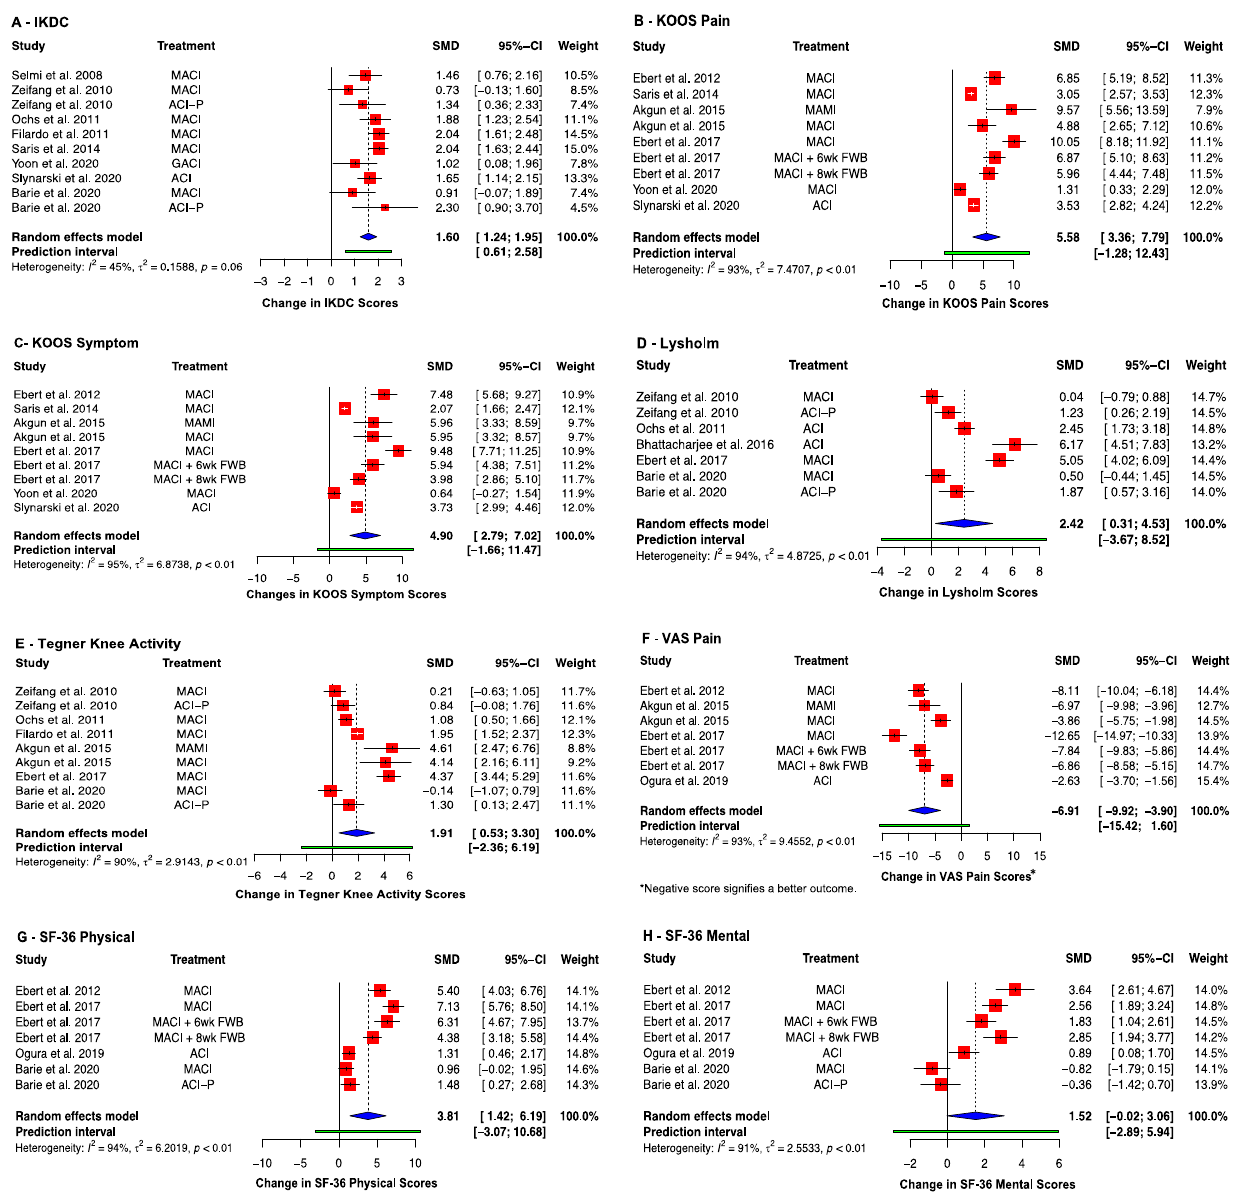
Figure 5. Forrest plots on the improvement of clinical scoring systems after receiving implant therapy: ( A ) IKDC; ( B ) KOOS (Pain); ( C ) KOOS (Symptom); ( D ) Lysholm; ( E ) Tegner Knee Activity Scale; ( F ) VAS Pain; ( G ) SF-36 Physical; ( H ) SF-36 Mental. (Abbreviations: MACI, Matrix-induced autologous chondrocyte implantation; ACI-P, ACI with periosteal flap cover; GACI, gel-type ACI; MAMI, Matrix-induced autologous mesenchymal stem cell implantation; FWB, full weight-bearing; Score; SF-36, Short Form-36; VAS, Visual Analogue Scale; SMD, standardized mean difference;